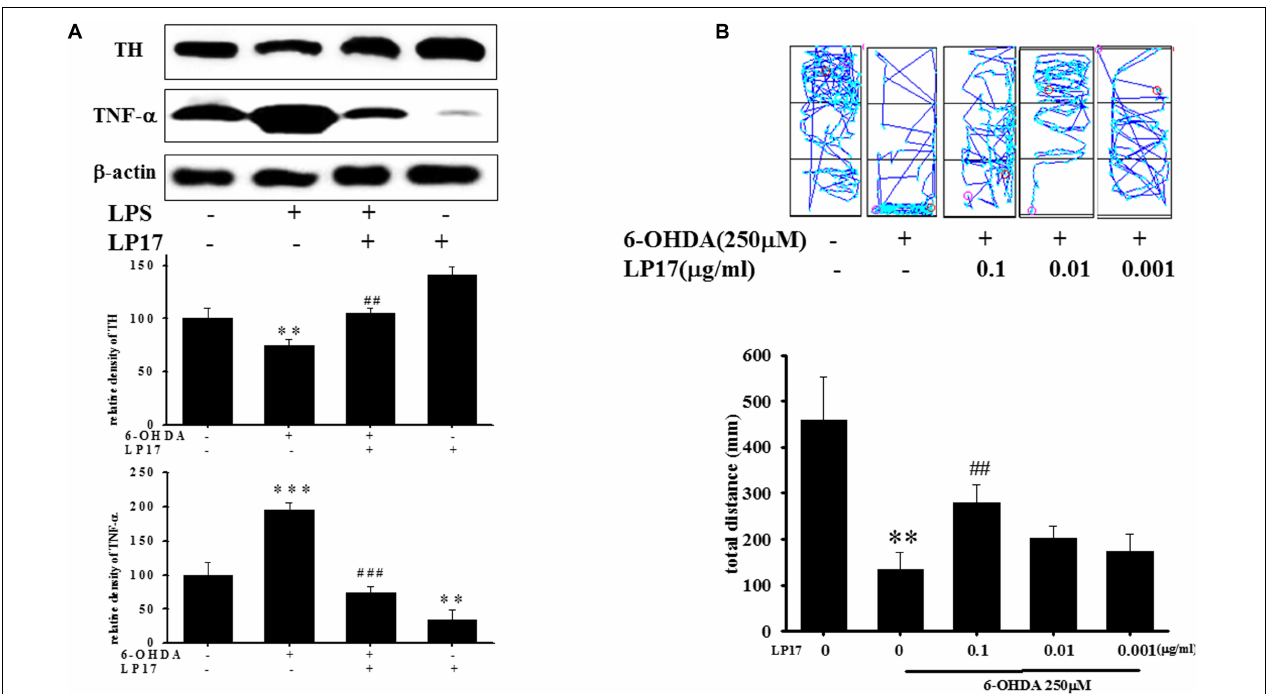
FIGURE 7 | Treatment of LP17 reversed 6–OHDA–induced downregulation of TH expression, upregulation of TNF- α expression, and locomotor deficit. (A) Western blot analyses for TH and TNF- α expression at 5 dpf of control, 6-OHDA, 6-OHDA plus LP17, and LP17 group after the zebrafish were treated with 0.001, 0.01, and 0.1 µ g/ml LP17 (from 9 hpf to 4 dpf) and with 250 µ M 6–OHDA (from 2 to 4 dpf) ( n = 3/group). It showed that LP17 significantly reversed the 6-OHDA-induced downregulation of TH and attenuated the 6–OHDA–induced upregulation of TNF- α expression. Each sample contained 20 zebrafish heads. (B) Determination of the typical swimming pattern and total swimming distance of zebrafish larvae at 5 dpf in the control, 6–OHDA, 6–OHDA plus LP17, and LP17 groups ( n = 16/group) shows that 0.1 µ g/ml of LP17 significantly reversed the 6–OHDA–induced deficiency of locomotor activity in 5 dpf. The bars represent the mean ± SEM. The data were analyzed using two-way ANOVA. ∗∗ P < 0.05, ∗∗∗ P < 0.001 versus the control group; ## P < 0.05; ### P < 0.001 versus the 6-OHDA